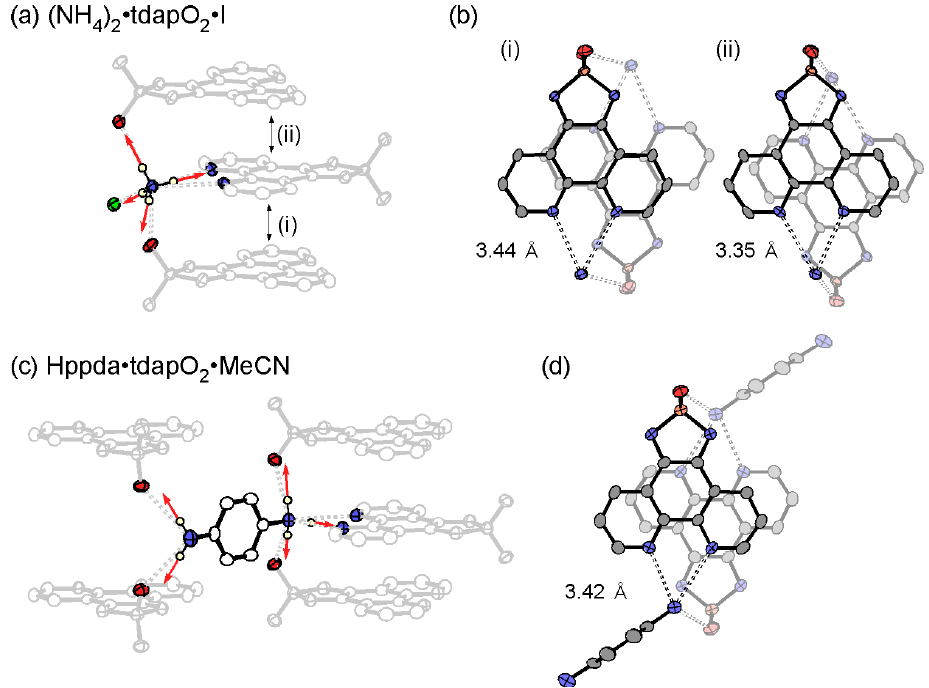
•MeCN (bottom). Adapted with 2